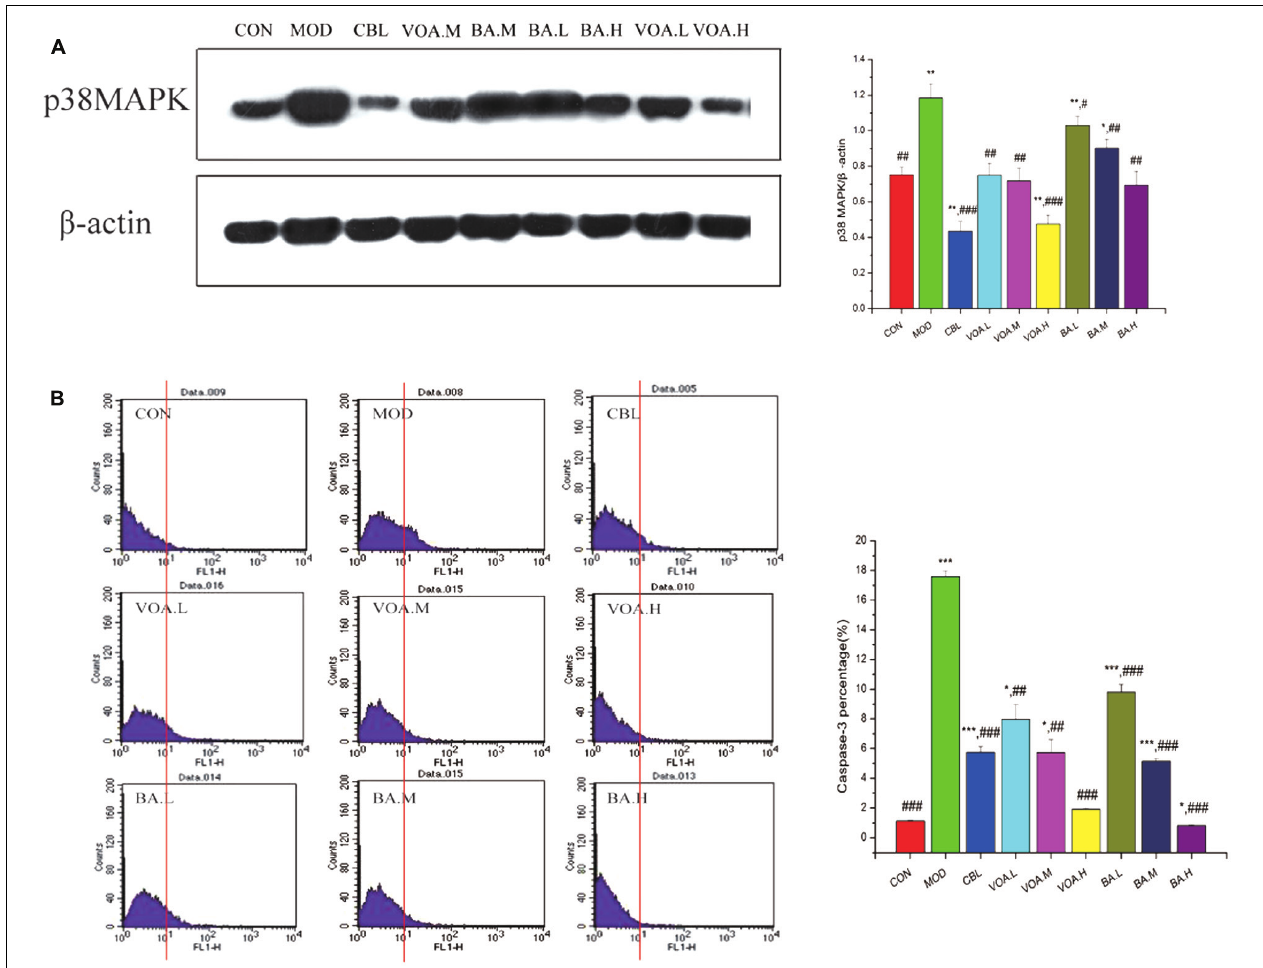
FIGURE 6 | (A) Reduction of p38 MAPK expression by VOA and BA in small intestinal tissue after 5-FU treatment, n = 6. 5-FU increased the p38 MAPK expression compared to the controls. GLB, VOA, and BA reduced p38 MAPK ( p < 0.001, p < 0.01, and p < 0.001). (B) Reduction of elevated caspase-3 by VOA and BA in small intestinal tissue after 5-FU treatment, n = 6. In the histogram, the data of the horizontal coordinates that were more than 10 1 were counted and were used as original data to draw the bar chart. Histogram of data from 5-FU shows significantly increased caspase-3 expression compared to the controls. VOA or BA reduced caspase-3 ( p < 0.01 and p < 0.001). Values are means ± SD. ∗ Significant difference compared to the controls. # Significant difference compared to the model and controls. ∗ p < 0.05, ∗∗ p < 0.01, ∗∗∗ p < 0.001, # p < 0.05, ## p < 0.01, and ### p <